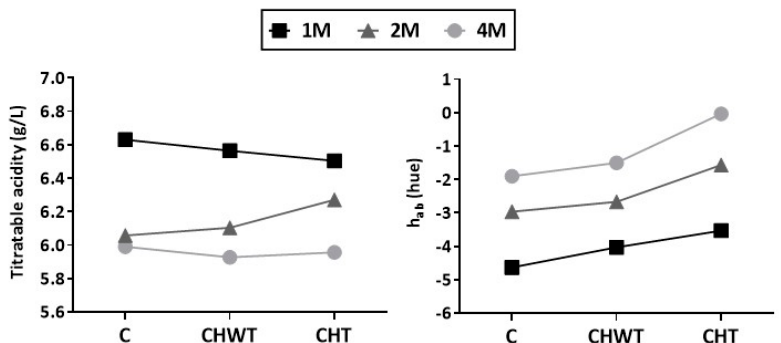
Figure 4. Interaction plots of aging time (F1) and vine-shoots treatments (F2) for analytical parameters in Bonarda wines by two-way ANOVA. C, control; CHWT, untoasted vine-shoot chips; CHT, toasted vine-shoot chips; 1M, 30 days; 2M, 60 days; 4M, 120 days.